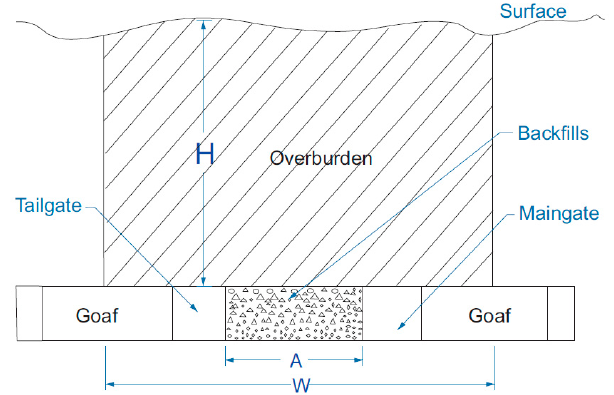
Figure 10. Illustration of the relationship between the overburden and backfills.